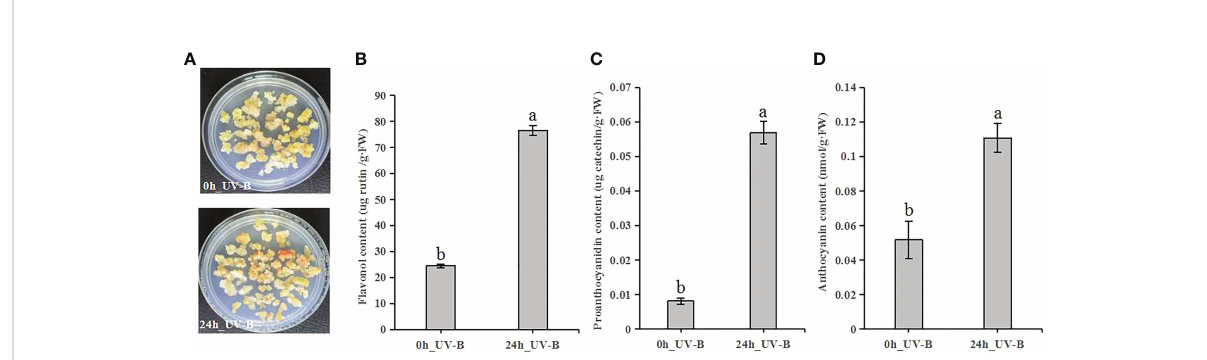
FIGURE 3 UV-B exposure induces fl avonoid accumulation in blueberry calli. (A) Representative blueberry calli before (0 h) and after (24 h). (B-D) Contents of fl avonol (B) , proanthocyanidin (C) and anthocyanin (D) after UV-B radiation for 0 h or 24 h Error bars indicate ± SD of the mean of three independent biological replicates. Different letters indicate signi fi cant differences ( p < 0.05) among samples by Tukey ’ s